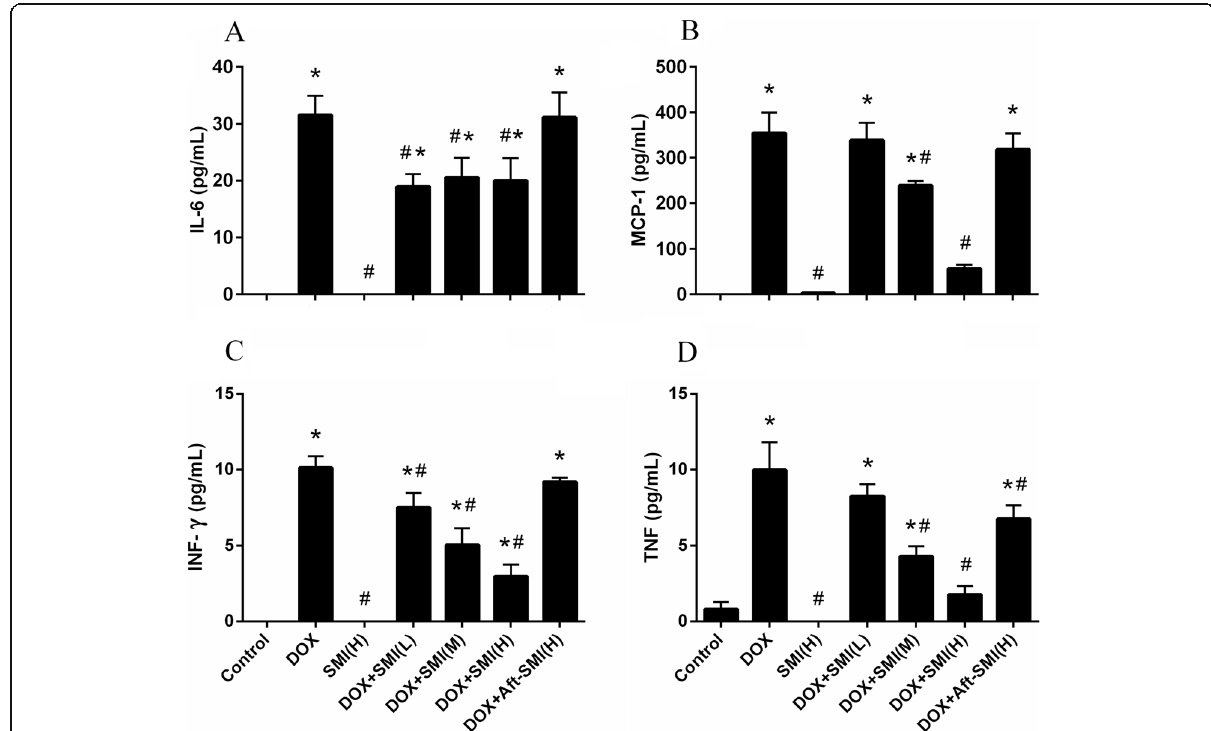
Fig. 6 Levels of IL-6 ( a ), MCP-1 ( b ), INF- γ ( c ) and TNF ( d ) in the serum of mice. (Means ± S.D., n = 10). *, significantly different ( P < 0.05) from respective values in the control group; #, significantly different ( P < 0.05) from respective values in the DOX